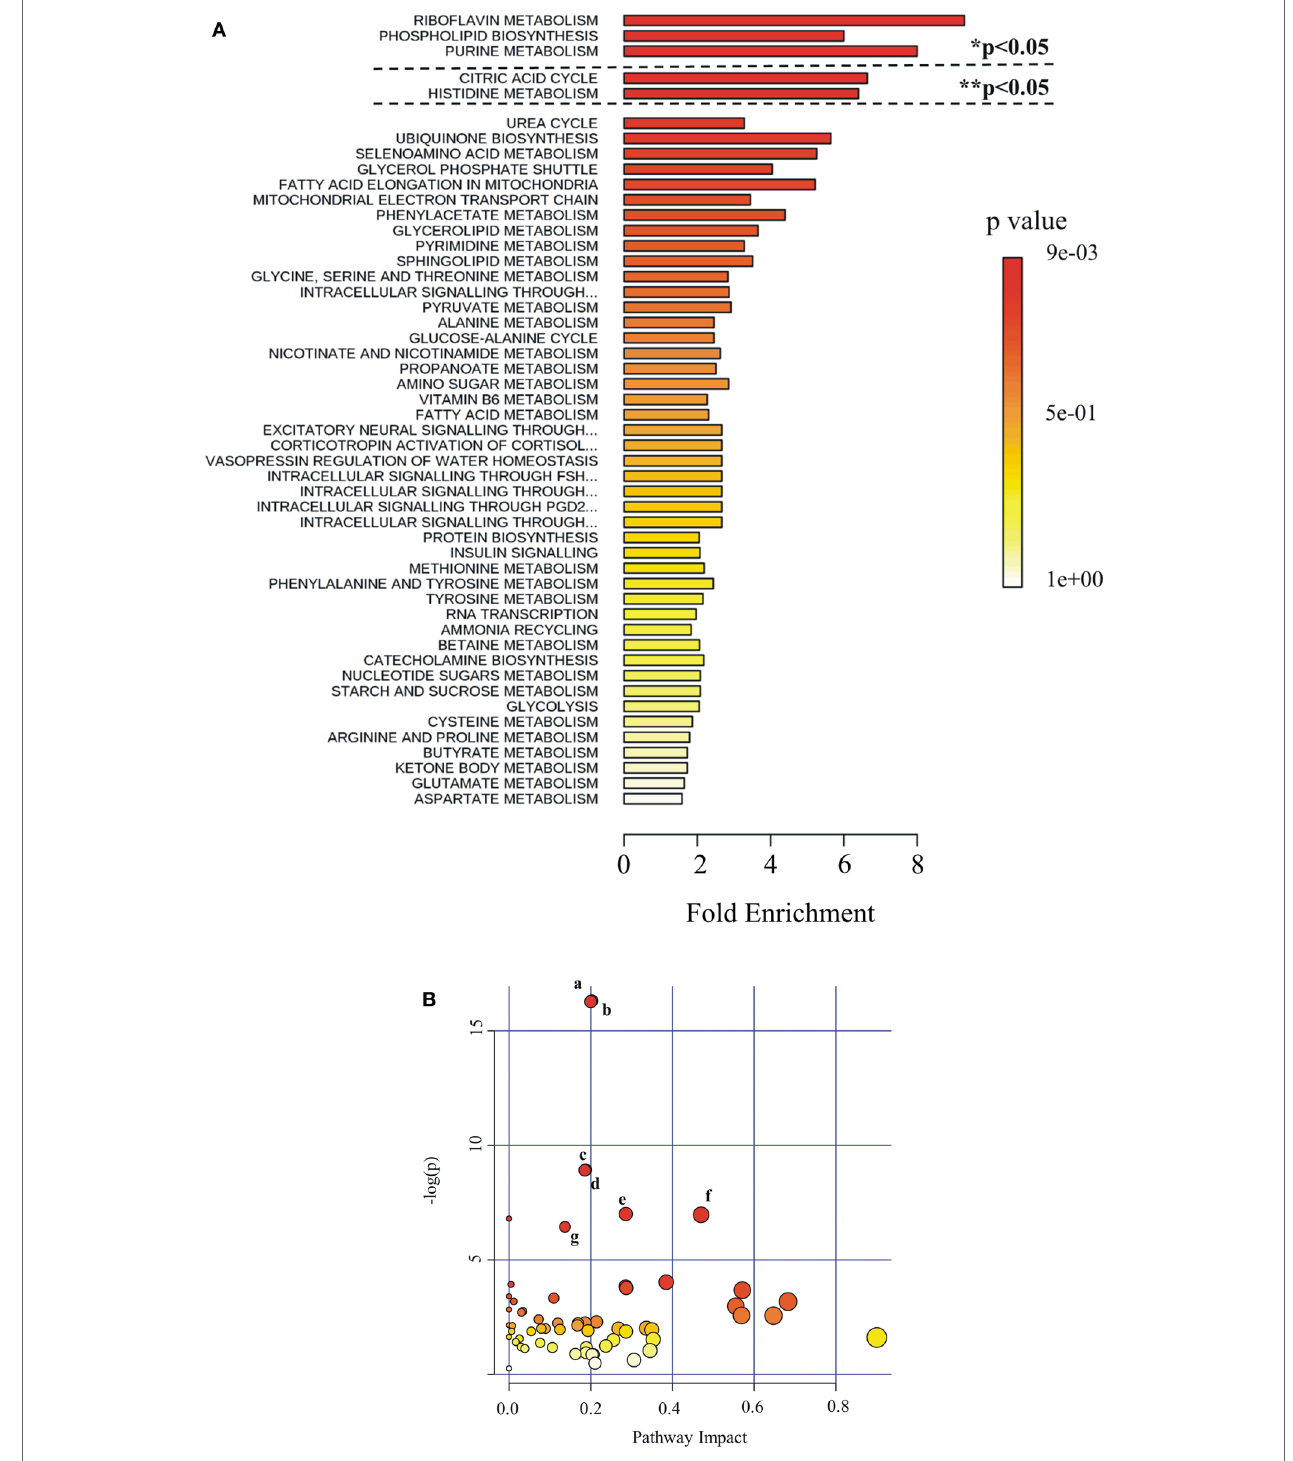
FigUre 6 | Pathway analysis as generated by MetaboAnalyst software package. Identified metabolites and their relative quantity were used to calculate the enrichment and statistical significance. (a) Metabolite set enrichment analysis (MSEA). Top 50 perturbed pathways are shown. The dashed lines indicate the cutoff of the adjusted p -value (*Holm; ** FDR). (B) Metabolic pathway analysis (MetPA). All the matched pathways are displayed as circles. The color and size of each circle are based on p -value and pathway impact value, respectively. The most impacted pathways having high statistical significance scores are indicated with letters: a, glycerolipid metabolism; b, glycerophospholipid metabolism; c, purine metabolism; d, riboflavin metabolism; e, glyoxylate and dicarboxylate metabolism; f, tricarboxylic acid cycle; g, inositol phosphate metabolism.